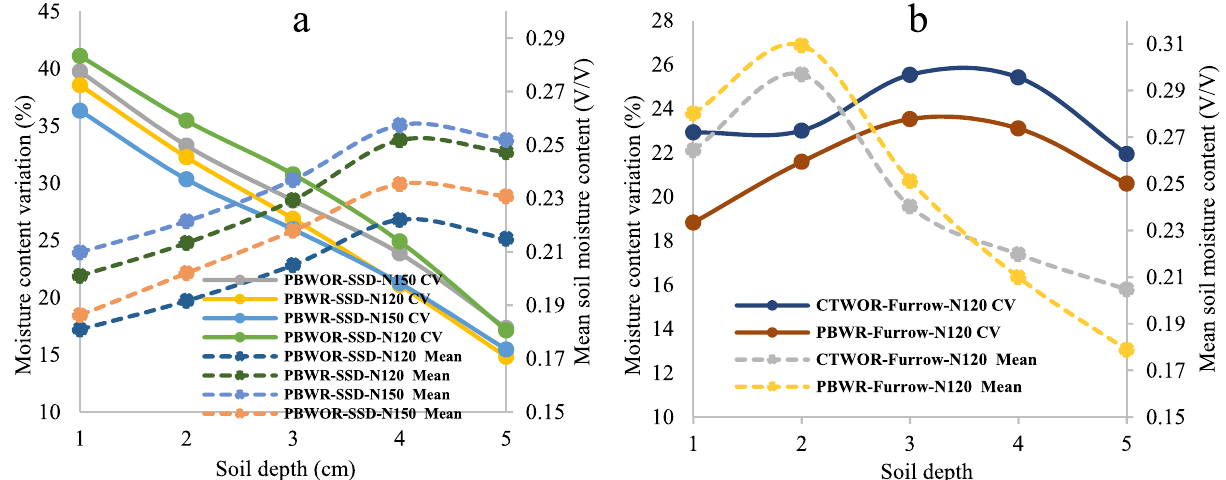
Figure 6. Variability in soil moisture content (primary axis) and mean moisture content (V/V) (secondary axis) of treatments with SSD and furrow irrigation during simulation period (8–89 DAS). Soil depth 1,2,3,4 and 5 corresponds to 0–5 cm, 5–10 cm, 10–15 cm, 15–30 cm and 30–45 cm soil depths, respectively. For treatment details please see Table